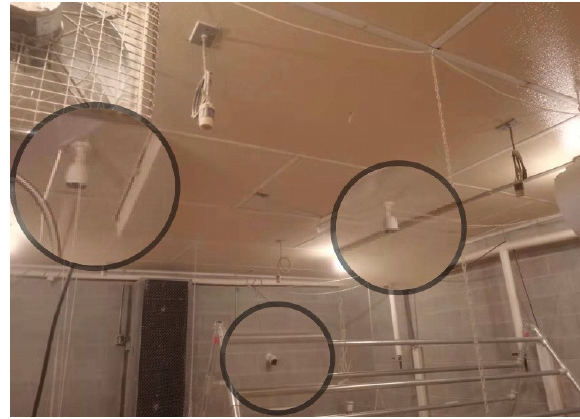
Figure 2. Positions of installed cameras.